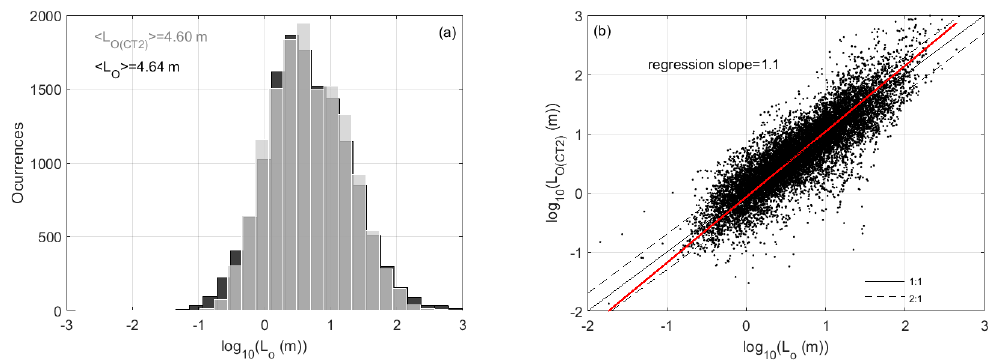
Figure 13. ( a ) Histograms of log 10 ( L O ) (black) and log 10 ( L O ( CT 2 ) ) (gray). ( b ) Scatter plot of log 10 ( L O ) Figure 13. ( a ) Histograms of 𝑙𝑜𝑔 (cid:2869)(cid:2868) (𝐿 (cid:3016) ) (black) and 𝑙𝑜𝑔 (cid:2869)(cid:2868) (𝐿 (cid:3016)((cid:3004)(cid:3021)(cid:2870)) ) (gray). ( b ) Scatter plot of 𝑙𝑜𝑔 (cid:2869)(cid:2868) (𝐿 (cid:3016) ) Figure 13. ( a ) Histograms of 𝑙𝑜𝑔 (cid:2869)(cid:2868) (𝐿 (cid:3016) ) (black) and 𝑙𝑜𝑔 (cid:2869)(cid:2868) (𝐿 (cid:3016)((cid:3004)(cid:3021)(cid:2870)) ) (gray). ( b ) Scatter plot of 𝑙𝑜𝑔 (cid:2869)(cid:2868) (𝐿 (cid:3016) ) vs. log 10 ( L O ( CT 2 ) ) . The red line is a regression line. vs 𝑙𝑜𝑔 (cid:2869)(cid:2868) (𝐿 (cid:3016)((cid:3004)(cid:3021)(cid:2870)) ) . The red line is a regression line. vs 𝑙𝑜𝑔 (cid:2869)(cid:2868) (𝐿 (cid:3016)((cid:3004)(cid:3021)(cid:2870)) ) . The red line is a regression line.